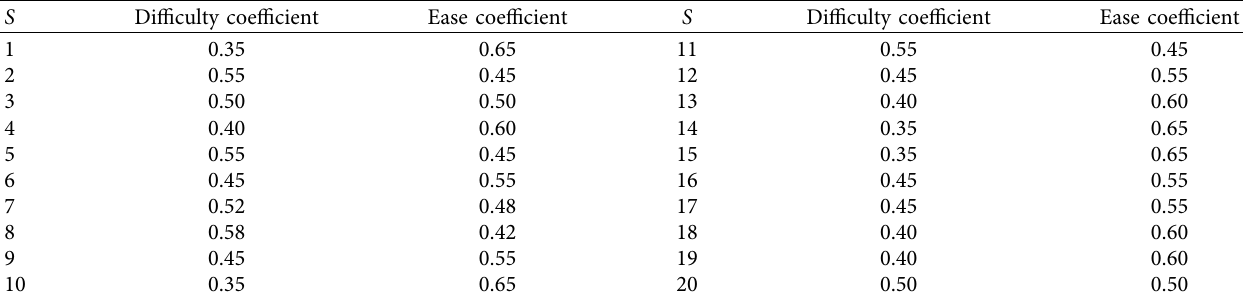
Table 1: The difficulty and ease coefficient of the basic science process test questions.